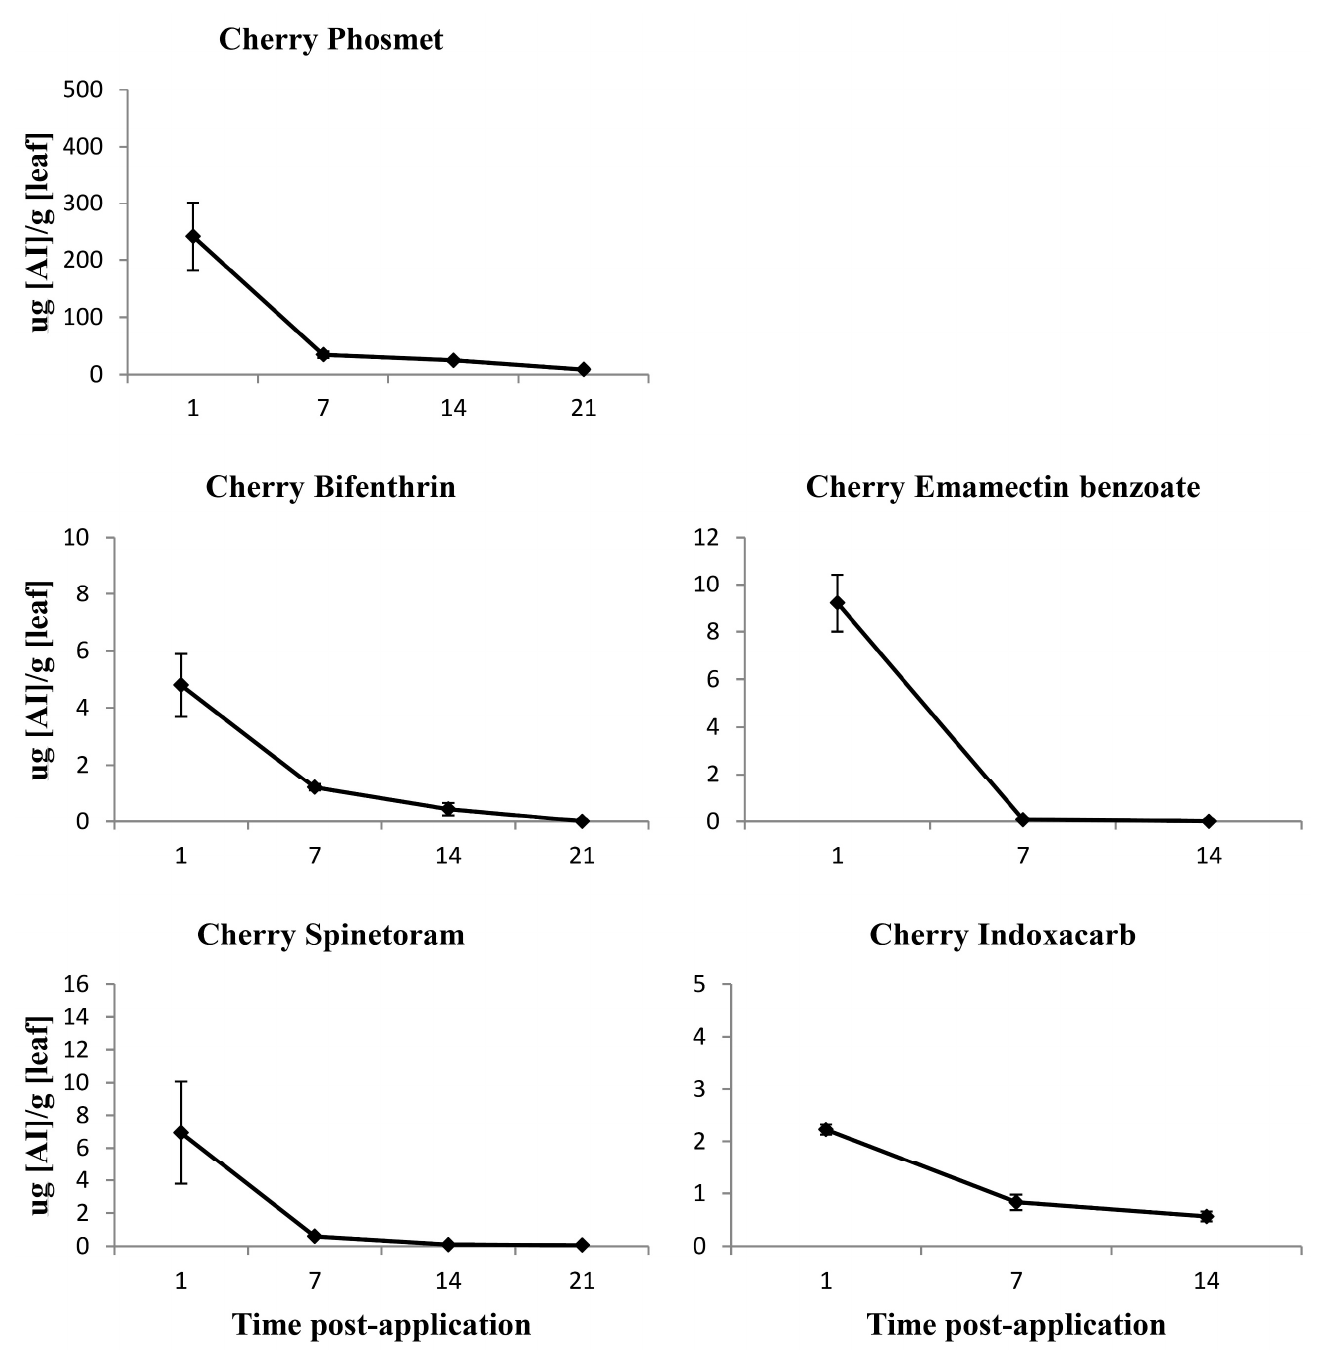
Figure 5. Residues means (SE ± ) measured in micrograms per gram of the active ingredient per leaf taken at 1, 7, 14, and 21-d post-application.